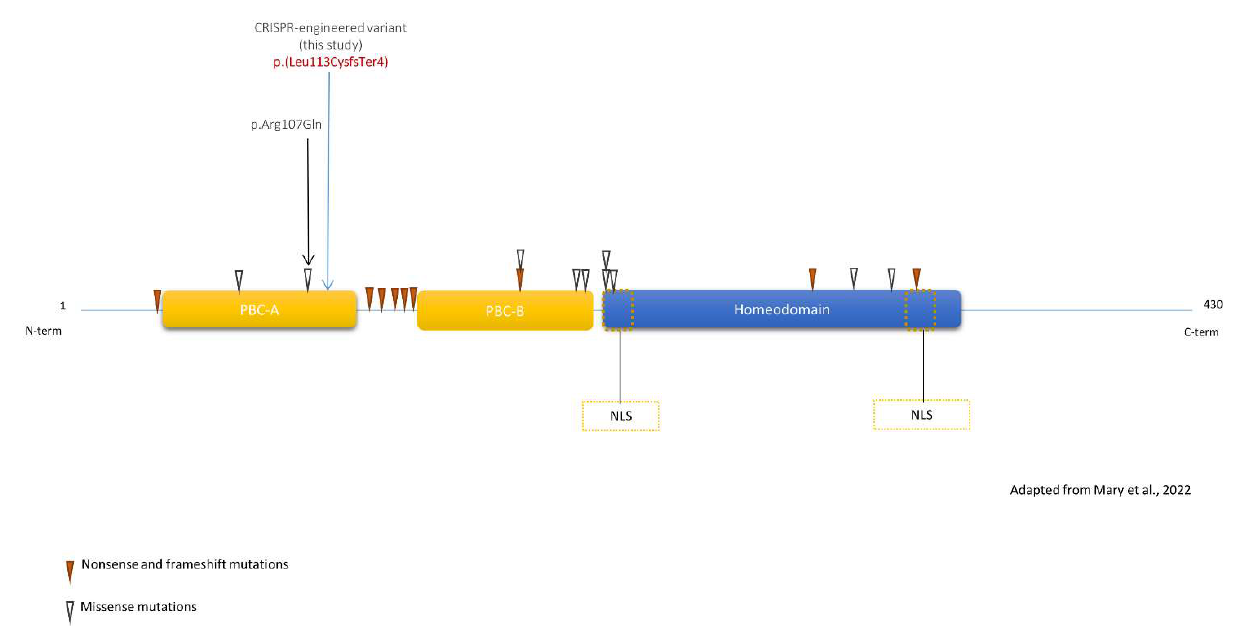
Figure 1. Schematic view of PBX1 with previously published variants. Blue arrow represents the CRISPR-engineered frameshift variant in clone KD2. Isoform: PBX1a - NM_002585.4 - NP_002576.1. All variants impact all PBX1 isoforms, except p.(Thr88Ile)(absent from NP_001340059). Yellow dotted boxes: Nuclear Localization Signal (NLS).